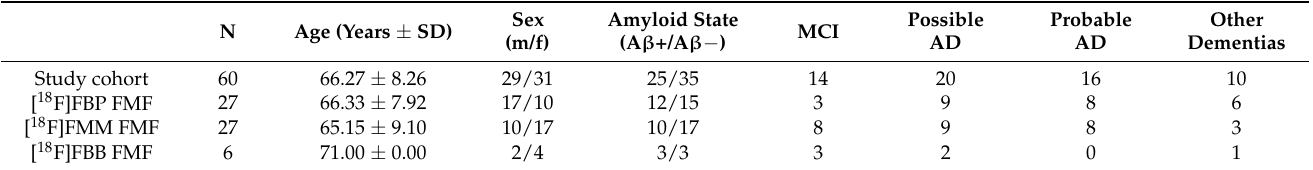
Table 1. Study cohort demographics. Classification in possible and probable AD was based on